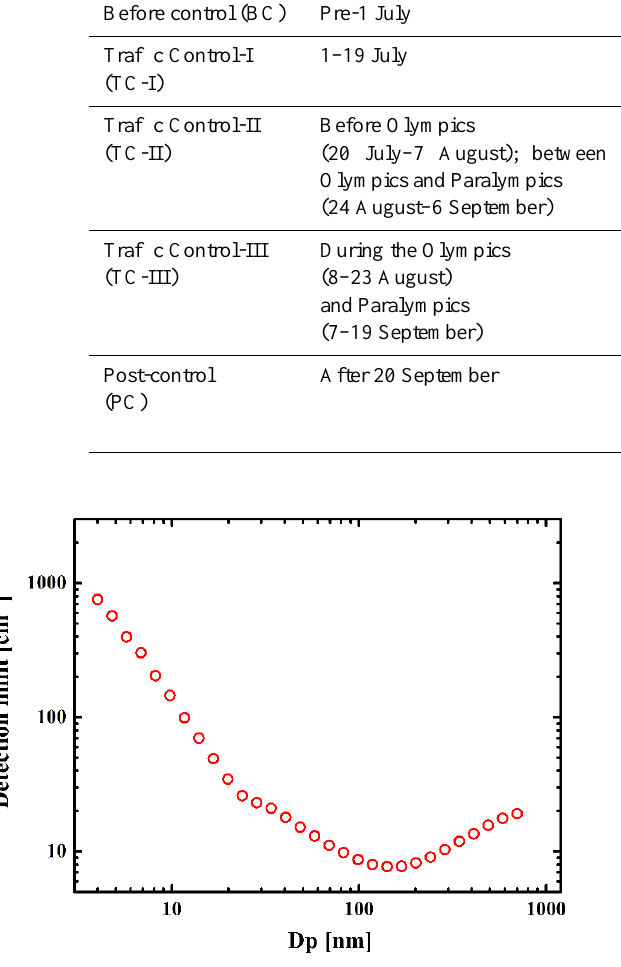
Figure 1: TDMPS detection limit versus particle diameter. 754 Fig. 1. TDMPS detection limit versus particle